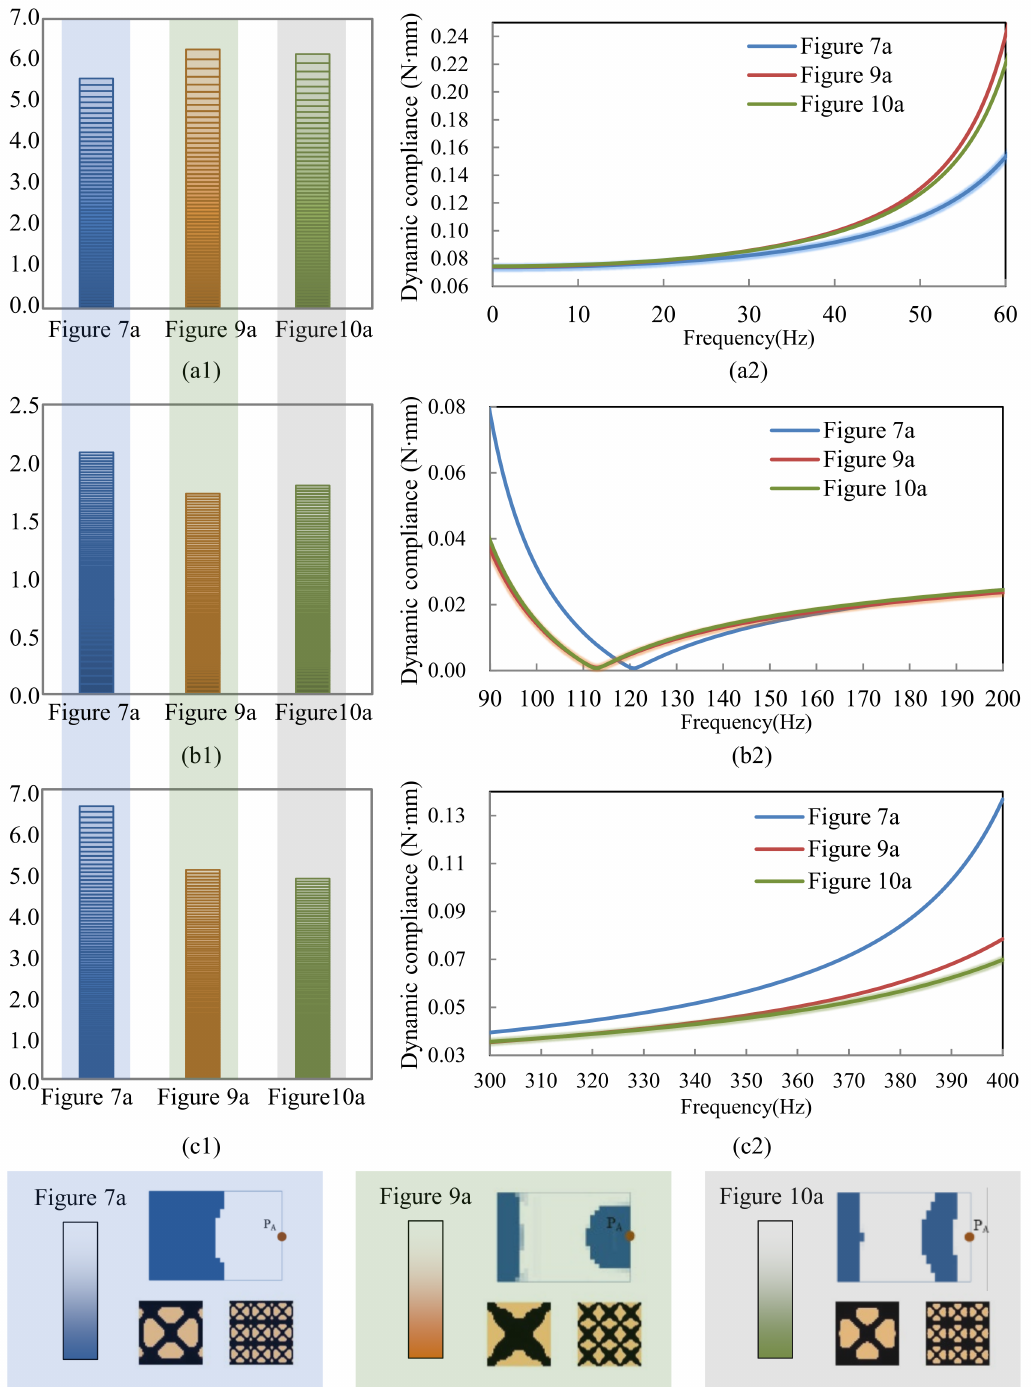
Figure 11. Dynamic compliance of the results shown in Figures 7a, 9a and 10a when thr excitation point is at P A . ( a1 ) the sum of dynamic compliance 0–60 Hz, ( a2 ) dynamic compliances vary with frequency 0–60 Hz. ( b1 ) the sum of dynamic compliance 90–200 Hz, ( b2 ) dynamic compliances vary with frequency 90–200 Hz. ( c1 ) the sum of dynamic compliance 300–400 Hz, ( c2 ) dynamic compliances vary with frequency 300–400